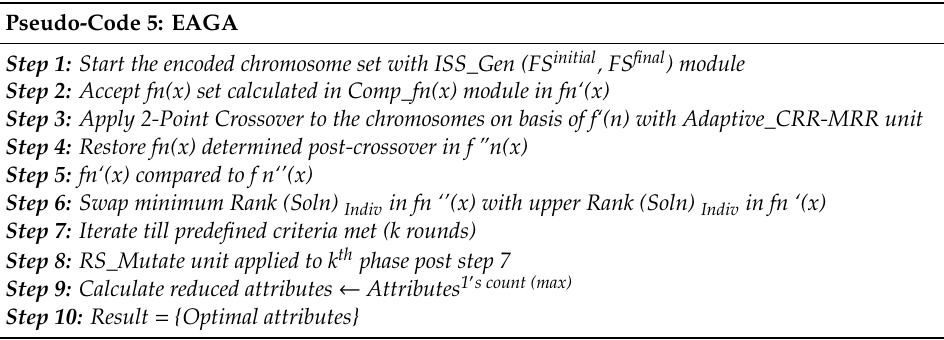
Table 8. Pseudo-code 5 for EAGA